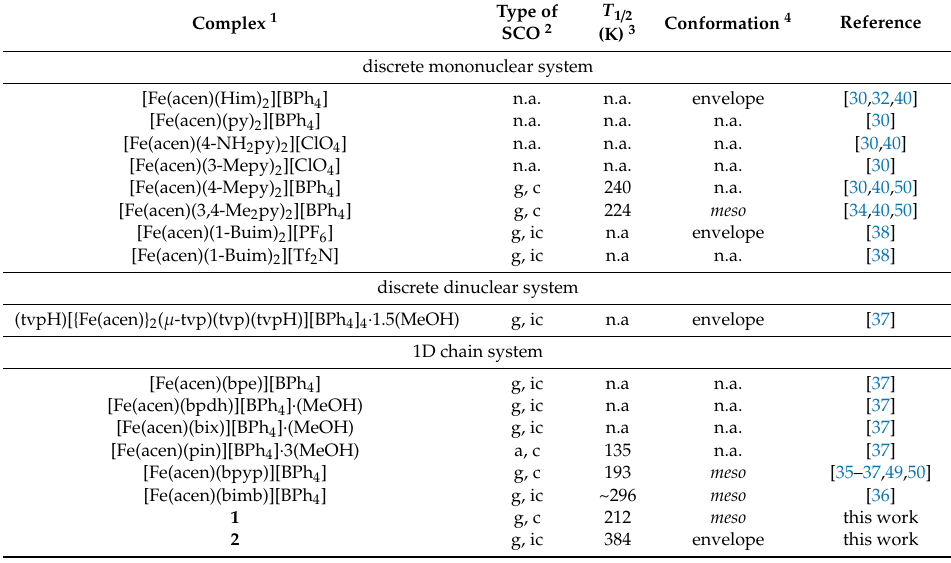
Table 5. Summary of Fe III (acen)-type SCO